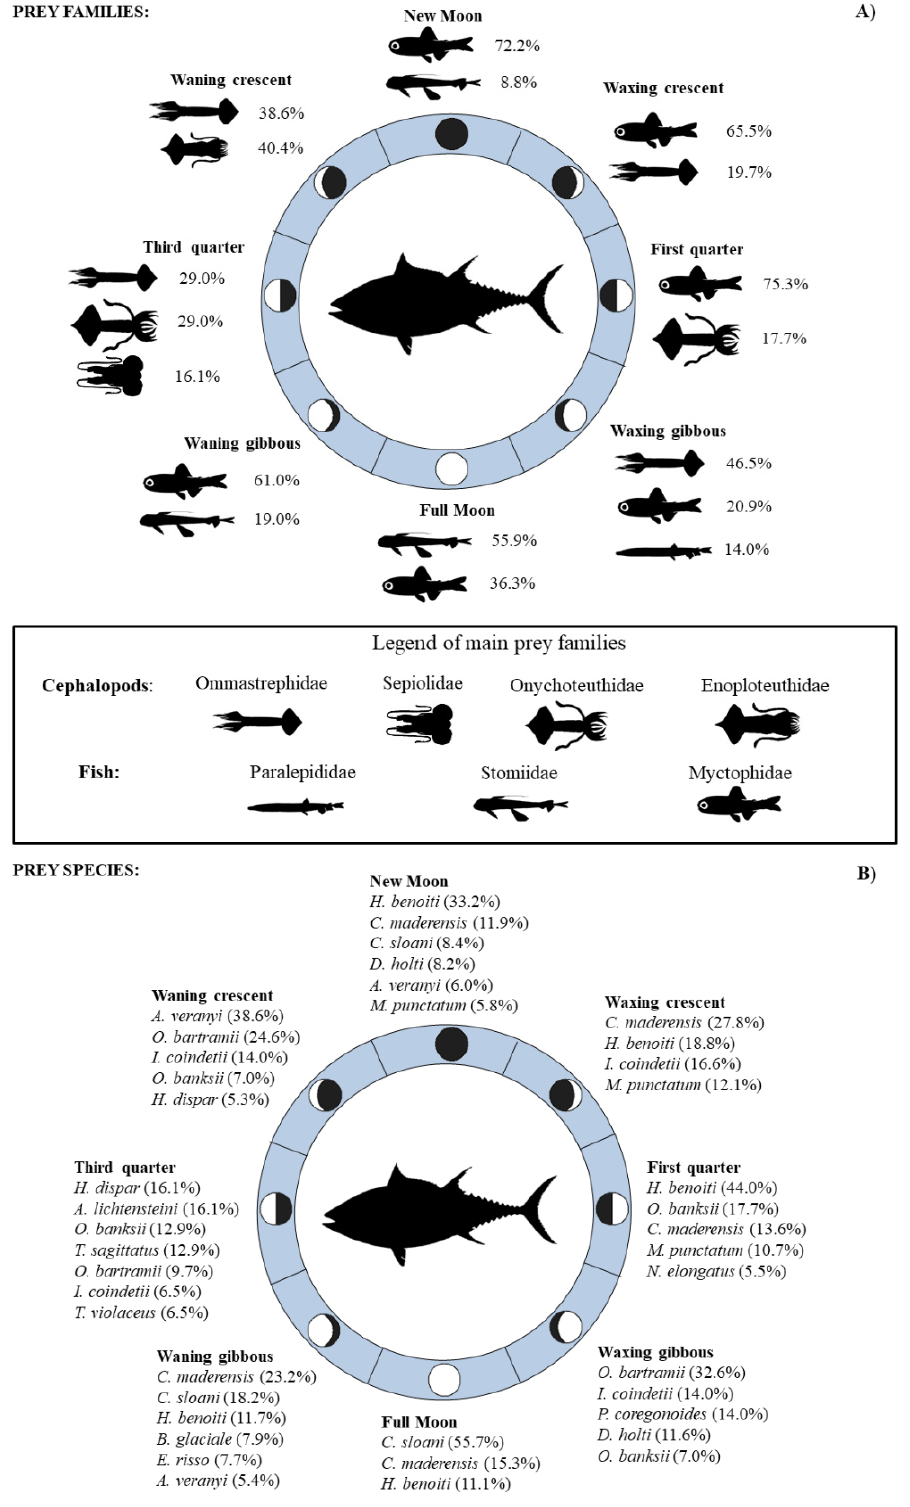
Figure 3. Abundance (%N) of the most important mesopelagic fish and cephalopod prey families ( A ) and species ( B ) consumed by BFT during the different moon phases in the Strait of Messina.